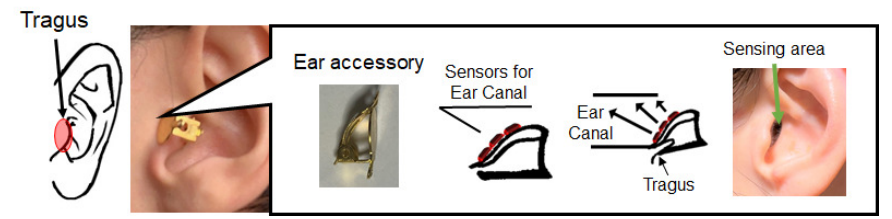
Figure 4. Tragus-mounted device. Reprinted/adapted with permission from Ref. [11]. 2021,